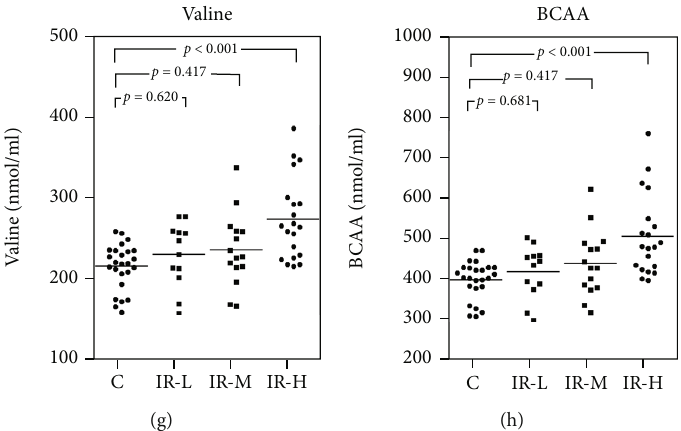
Figure 4: Intergroup comparisons for BCAAs in the control and T2DM groups. Statistical analysis was performed using the Steel – Dwass method. The horizontal solid lines indicate the mean values for each group. (a – d) CysC < 0 : 93 ; (e – h) Cys ≥ 0 : 93 . IR-L, T2DM with HOMA − IR ≤ 1 : 60 ; IR-M, T2DM with 1 : 6 < HOMA − IR < 2 : 5 ; IR-H, T2DM with HOMA − IR ≥ 2 : 5 . BCAAs: branched-chain amino acids; CysC: cystatin C; T2DM: type 2 diabetes mellitus; HOMA-IR: homeostasis model assessment of insulin resistance. Table 5: Plasma amino acid concentrations in each group.